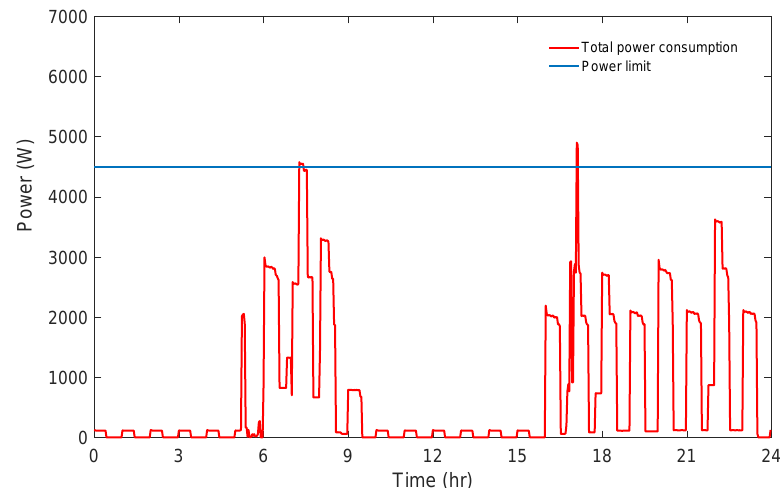
Figure 8. Power consumption graph of the highest priority solution for Scenario 1.